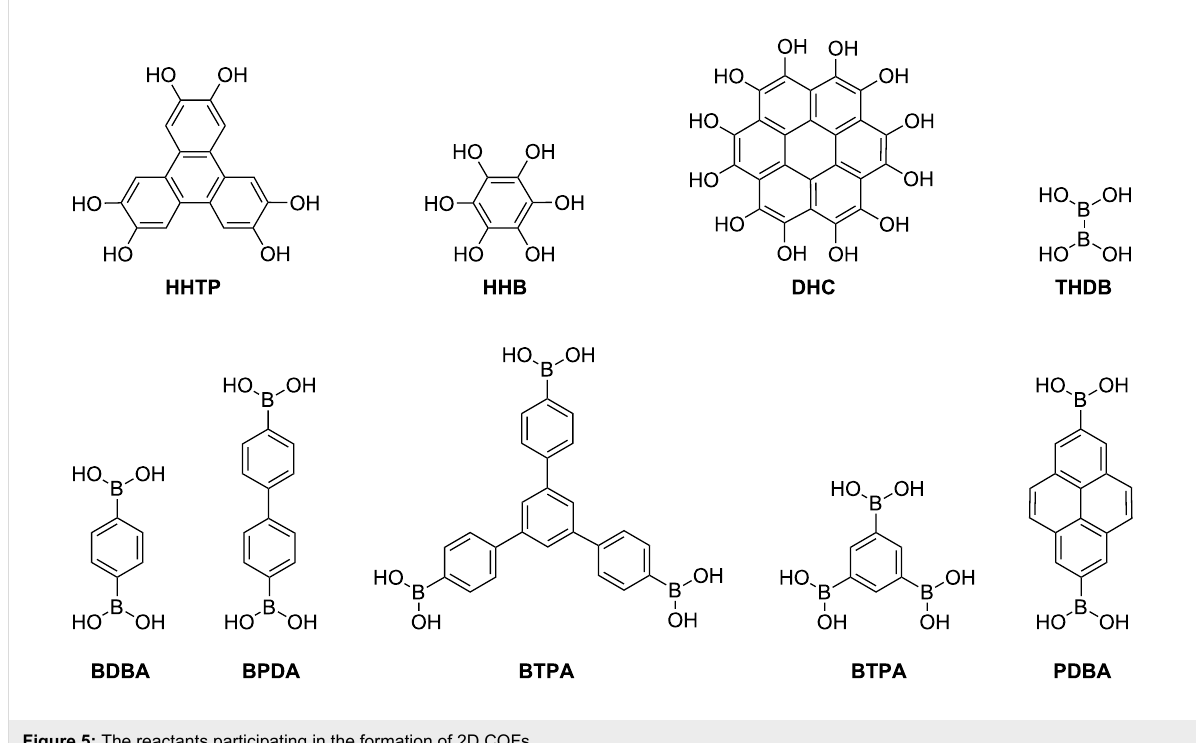
Figure 5: The reactants participating in the formation of 2D COFs.